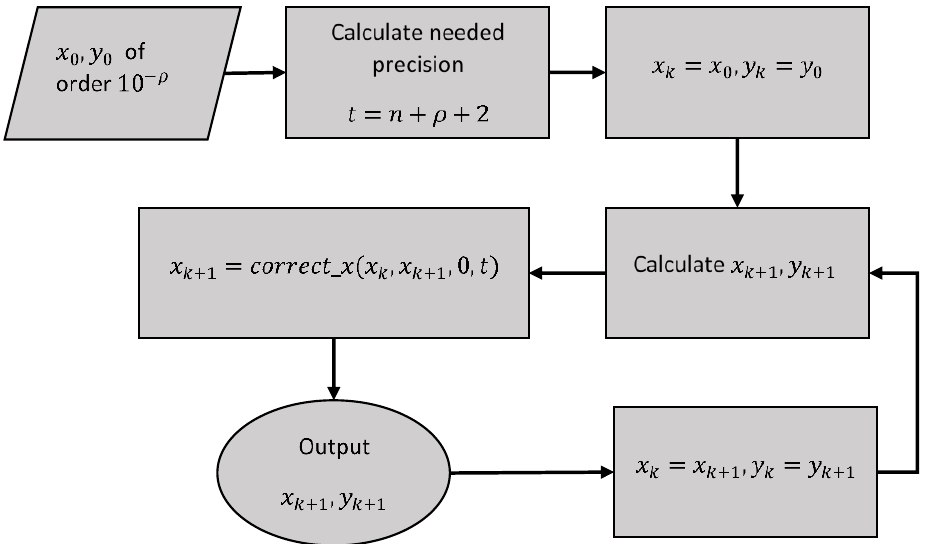
Figure 3. The chart of the entire flow of the Baker’s map, which generates finite precision error free results, for tens of millions of iterations. The present flowchart also employs the procedure correct_x introduced in the flowchart of Figure 1.